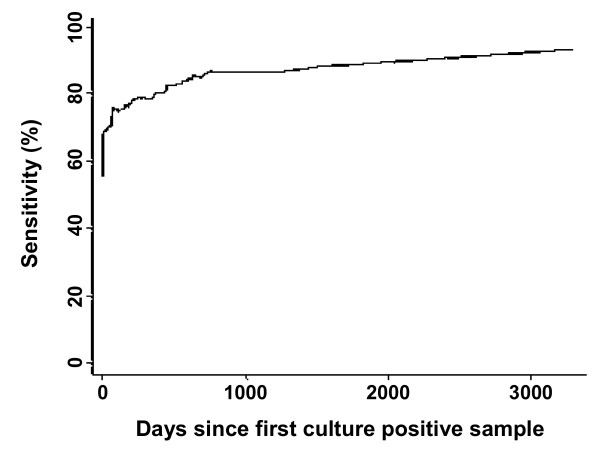
Brock Test sensitivity increases with duration after first positive culture sample. Running mean smoothed plot showing how sensitivity of the Brock Test increases with duration (days) after the first positive culture sample.